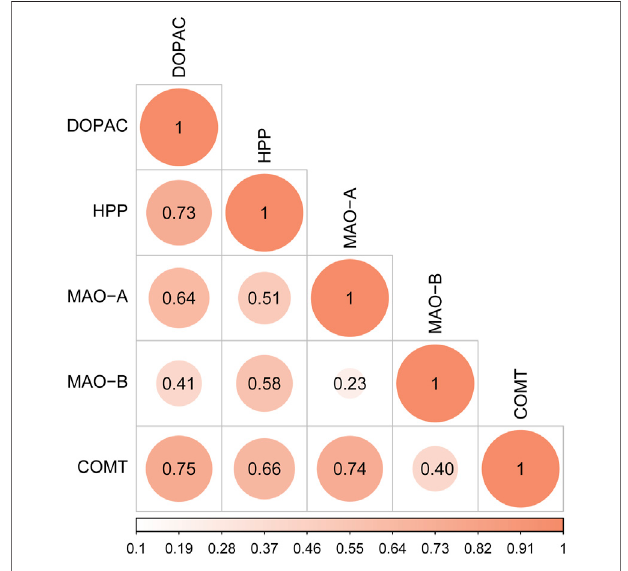
FIGURE 10 | Correlation analysis of key differentially expressed metabolites(DOPACandHPP)andkeytargets(MAO-A,MAO-B,andCOMT).